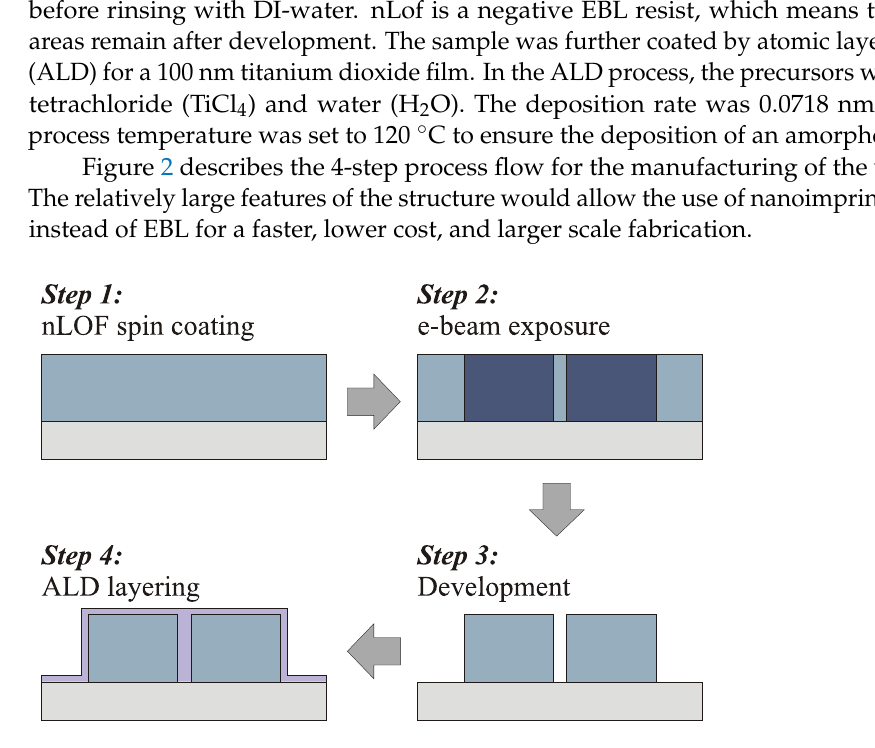
Figure 2. Process flow of the waveguide fabrication: resist deposition on an oxidized silicon wafer, electron-beam patterning of the nLof resist, development of the pattern, ALD coating of titania. Several patterns were fabricated. This included bends of different radii of curvature ( r ) as well as long waveguides. These patterns were categorised into three chips as shown in Figure 3. Each waveguide had an input and output taper part of 3 µ m width and 500 µ m length. In chip 1, the bend radius was kept at 100 µ m and the length L was varied from 500 µ m to 5 mm. Chip 2 presents waveguides with varying bend radii from 2 µ m